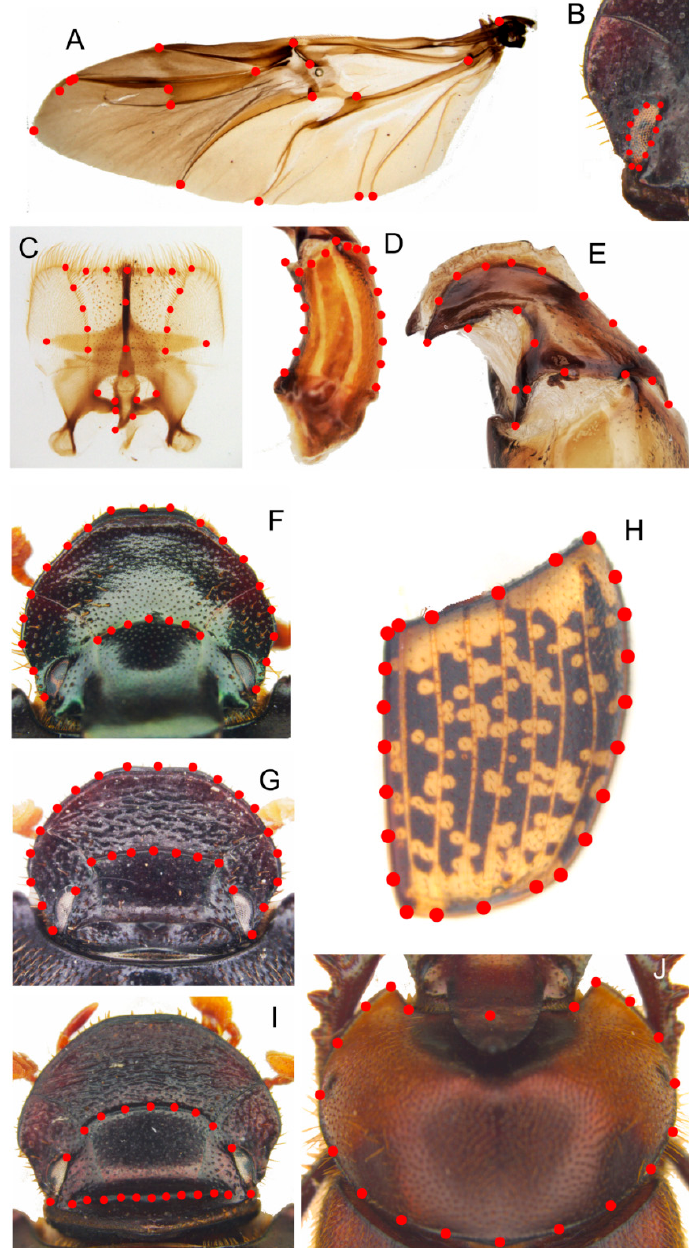
Figure 1. The landmark configurations employed in the analyses. (A) : Hindwing, 18 landmarks. (B) : Eye, 12 landmarks. (C) : Epipharynx, 27 landmarks. (D) : Phallobase, 19 landmarks. (E) : Paramere, 19 landmarks. (F) : Male head, 26 landmarks. (G) : Female head, 28 landmarks. (H) : Right elytron, 24 landmarks. (I) : Female carinae, 22 landmarks. (J) : Pronotum, 20 landmarks. For pronotum and eye, the same point configurations were applied in males and females, but the datasets were separately treated in the